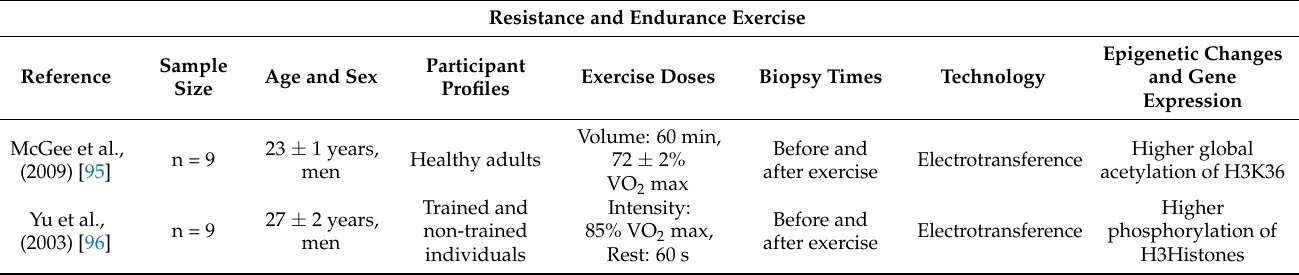
Table 2. Effects of endurance and resistance training on histone modification in skeletal